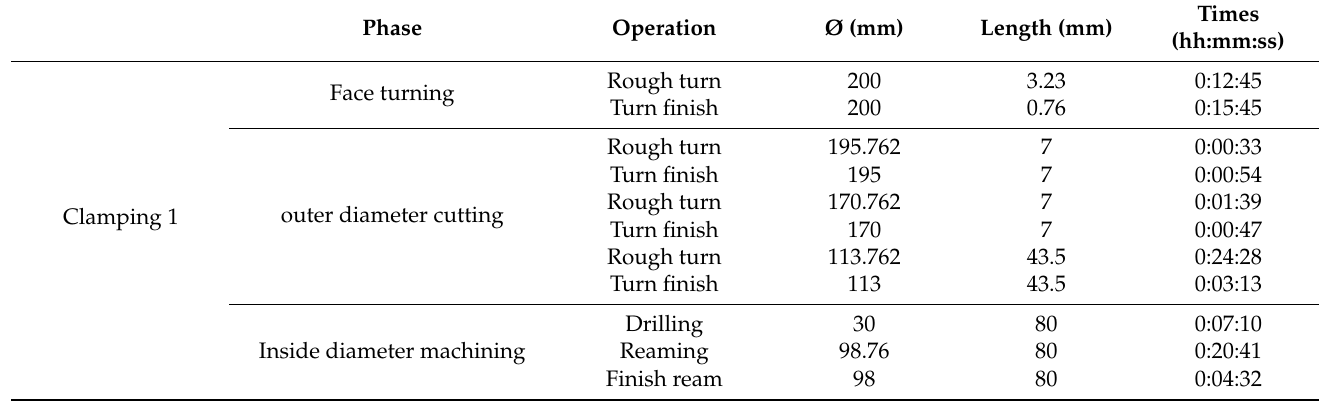
Table 6. Simulation of CNC lathe cutting times.